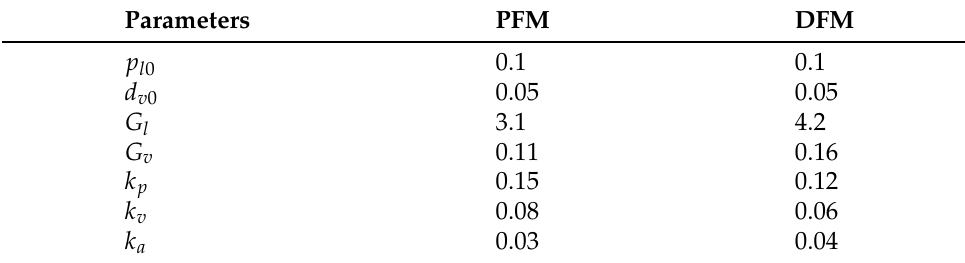
Table 3. The parameters of neural controller.